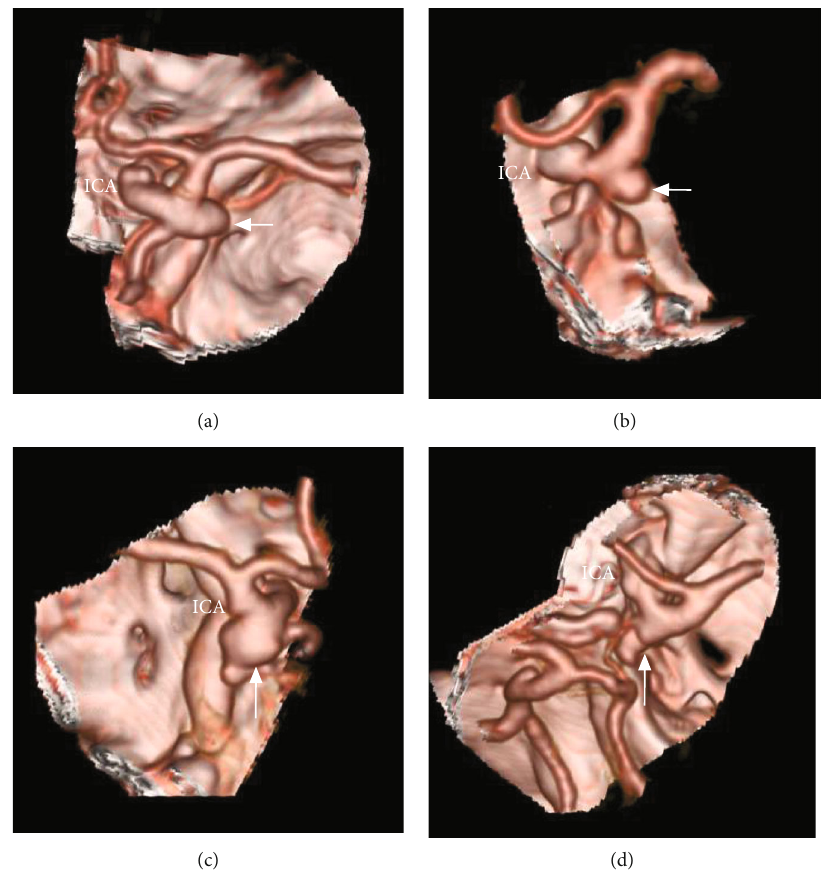
Figure 3: Aneurysm projection in CTA is as folows; (a – b) CTA showing that the aneurysm projected laterally (arrows). (c – d); CTA showing that the aneurysm projected posteriorly (arrows). Abbreviations: CTA: computed tomography angiography; ICA: internal carotid